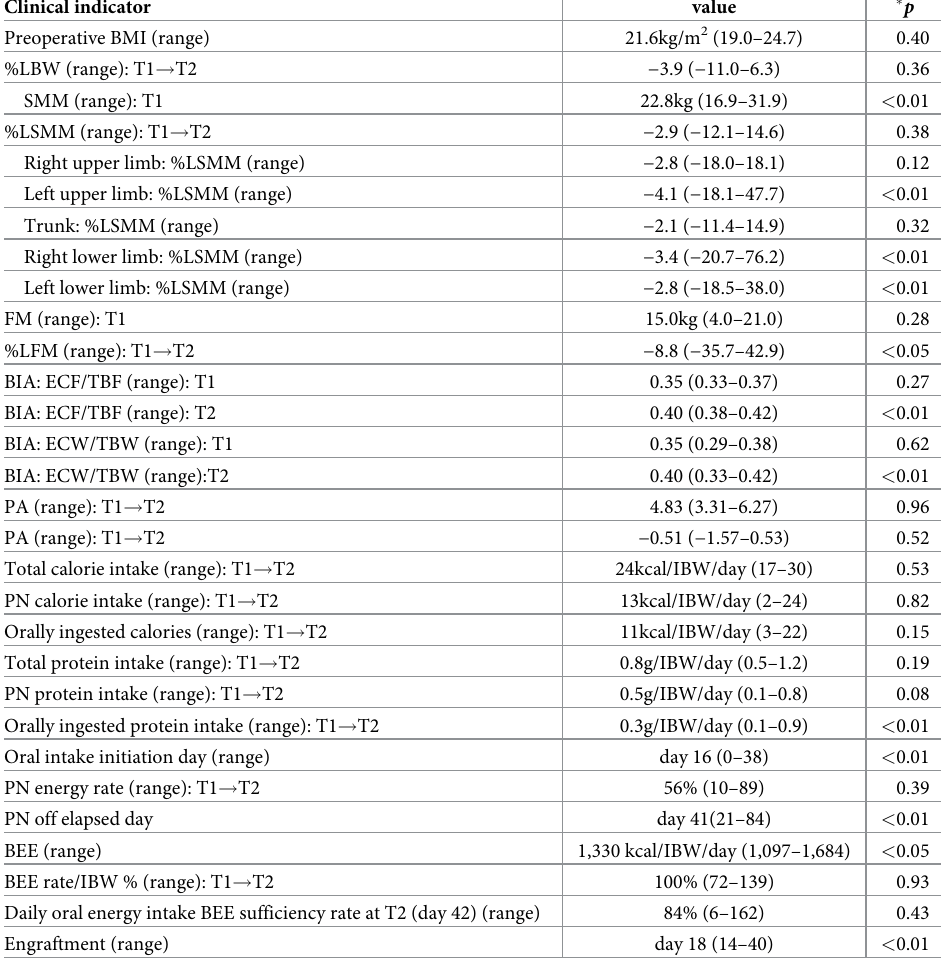
Table 4. Clinical indicators assessed during the nutritional pathway evaluation. Clinical